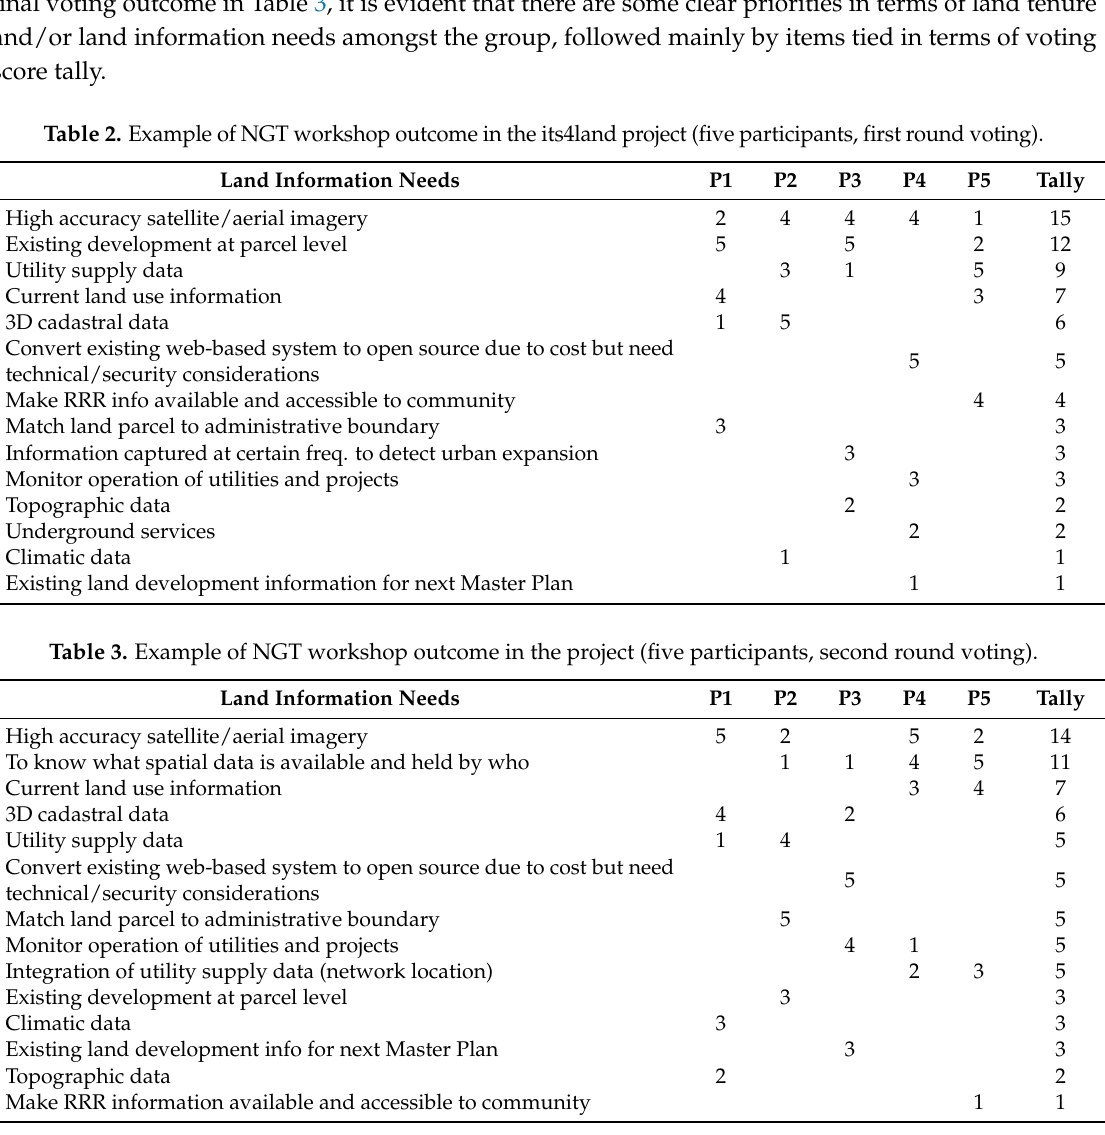
Utility supply data Convert existing web-based system to open source due to cost but need technical/security considerations Match land parcel to administrative boundary Monitor operation of utilities and projects Integration of utility supply data (network